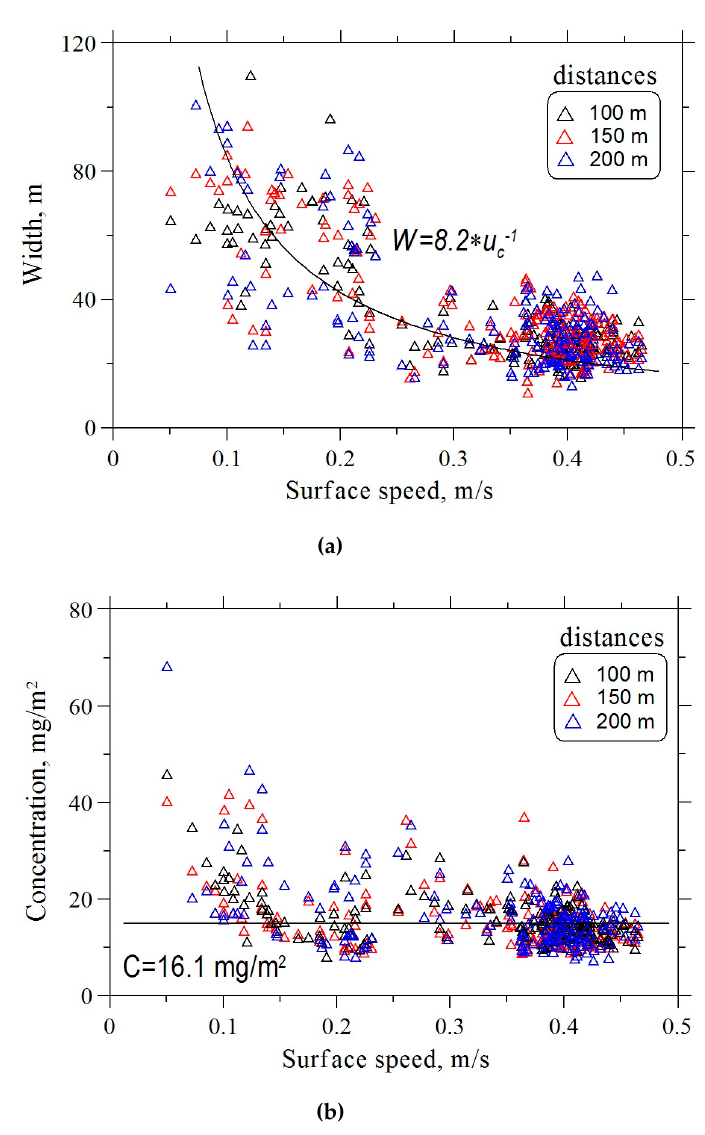
Figure 12. ( a ) Band width W and ( b ) surfactant concentration C as functions of surface speed u c at different distances from the SOP. Black curve is the best fit approximation of experimental data.